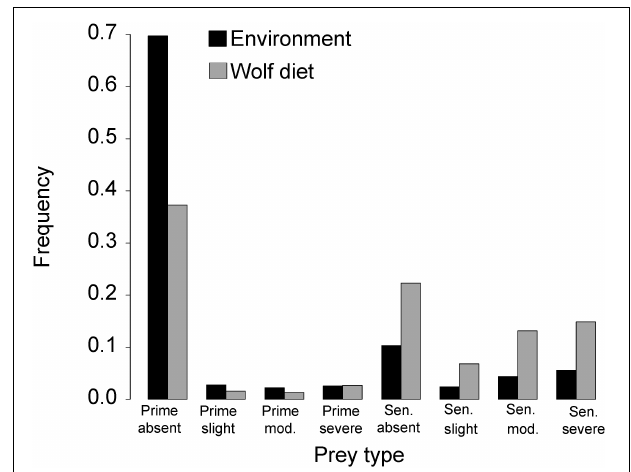
FIGURE 2 | Frequency of different types of moose in the environment and in wolf diets in Isle Royale National Park, 1959–2007. Moose were grouped according to age [prime-aged (1–9 years old) or senescent ( > 9 years old, abbreviated “Sen”)] and severity of OA [absent, mild, moderate (abbreviated to mod.), severe]. Black bars indicate environmental frequency, averaged across years. Gray bars indicate dietary frequency, averaged across